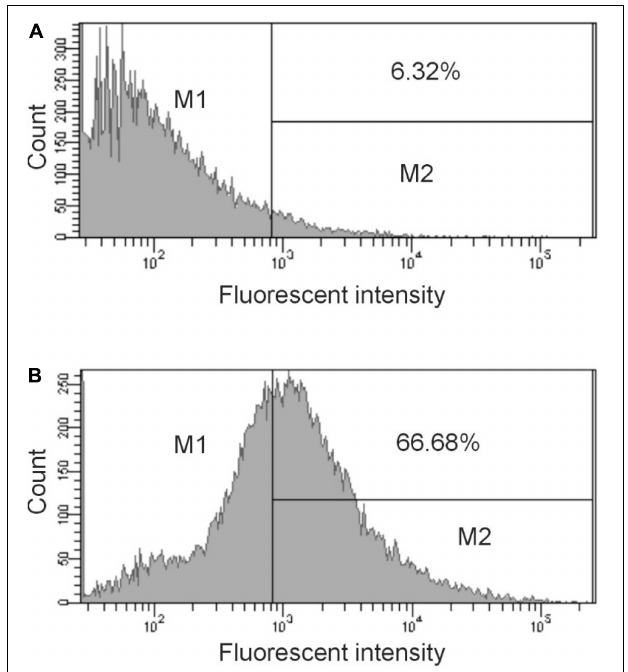
FIGURE 4 | Flow cytometry analysis of antibody binding to H. influenzae. Cells were treated with preimmunization sera (dilution 1:500) (A) or immunized sera (dilution 1:500) obtained after 28 days (B) followed by treatment with Cy3 goat anti-rabbit IgG (Life Technologies). The bacteria were analyzed by using FACS Calibur flow cytometer. Data were analyzed with CellQuest. Representative histograms from three independent experiments are shown. The bar in the figure represents the gate used to measure binding efficiency. The number in each figure corresponds to the percentage of the population that bound